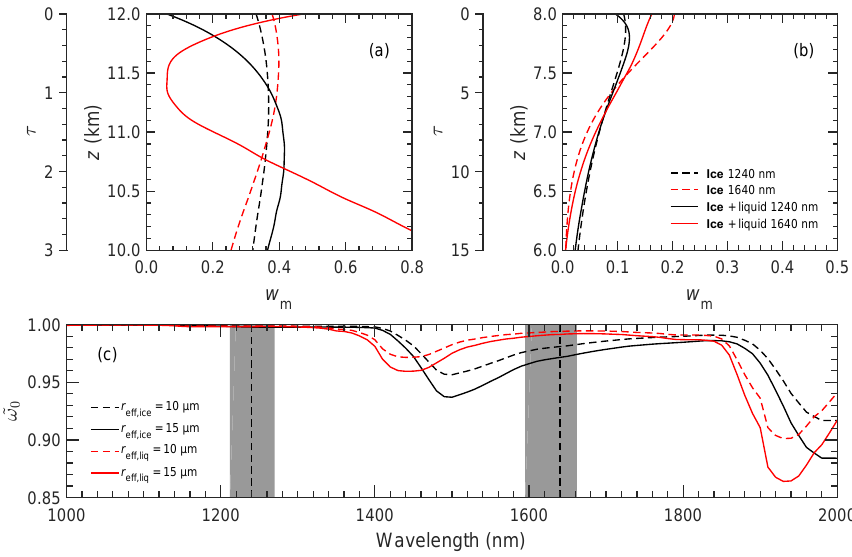
Figure 12. (a) The w m calculated for cloud A at λ = 1240 and 1640nm, while panel (b) is for cloud B. Solid line and dashed line describe w m calculated with and without the presence of underlying liquid water cloud, respectively. (c) Single scattering albedo e ω 0 of GHM and liquid water droplets with r eff of 10 and